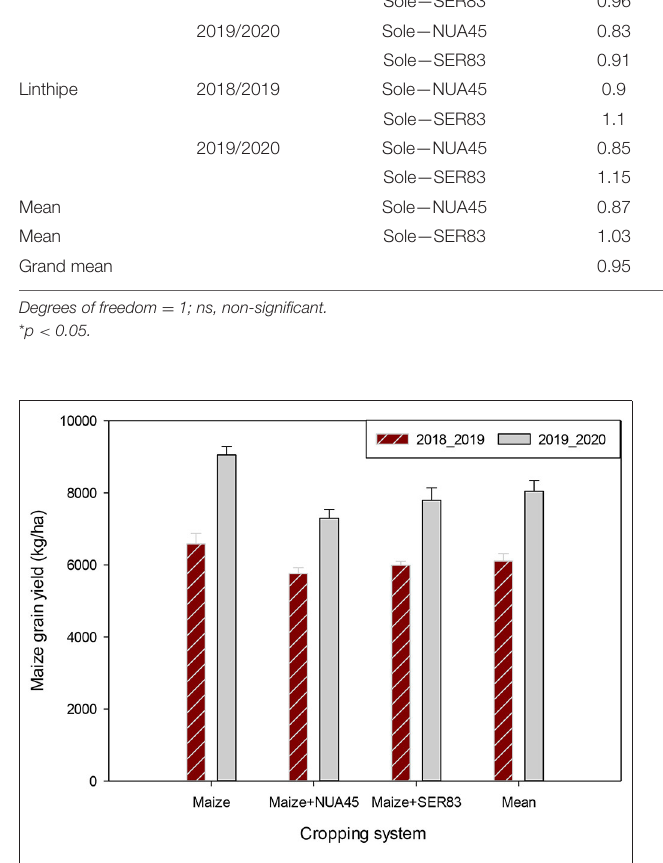
TABLE 6 | Means of partial land equivalent ratio (PLER) and total LER from intercropping a maize variety with two common bean varieties NUA45 and SER83 at Chitedze and Linthipe in 2019 and 2020. Location Year Cropping system Partial LER Total LER t -value t -sig Maize Common bean Chitedze